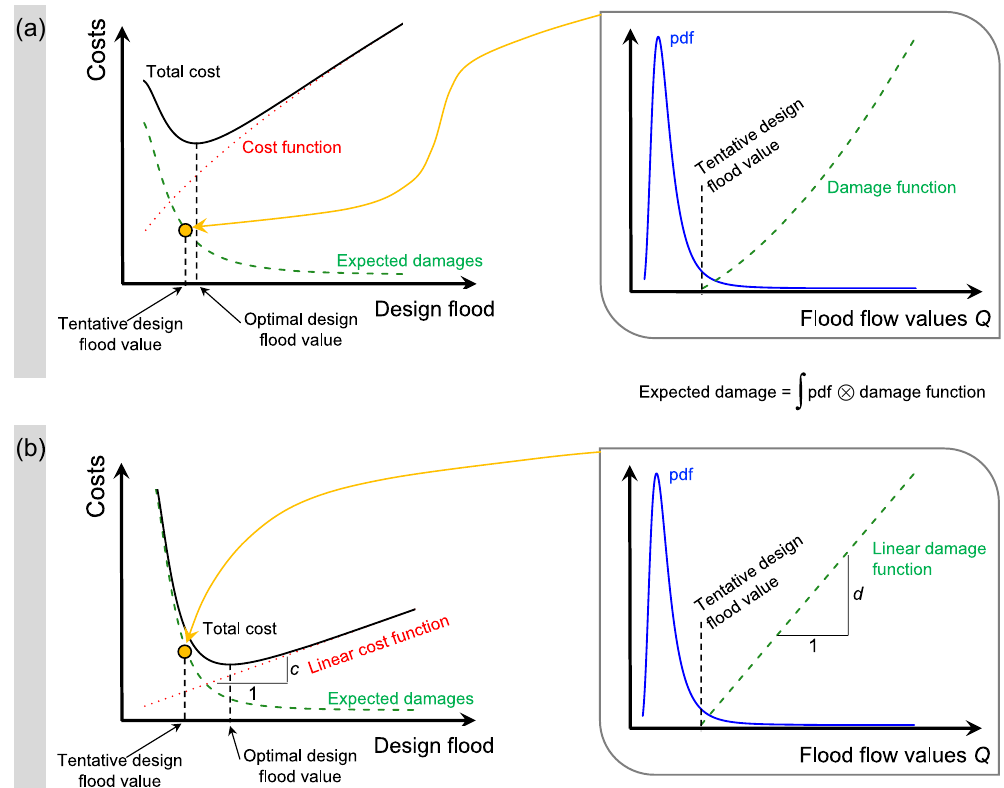
Figure 1. Illustrative example (without uncertainty) of the application of the cost–benefit framework to compute the design flood. Two generic cost and damage functions are reported in (a) , while (b) shows the linear functions adopted in the UNCODE